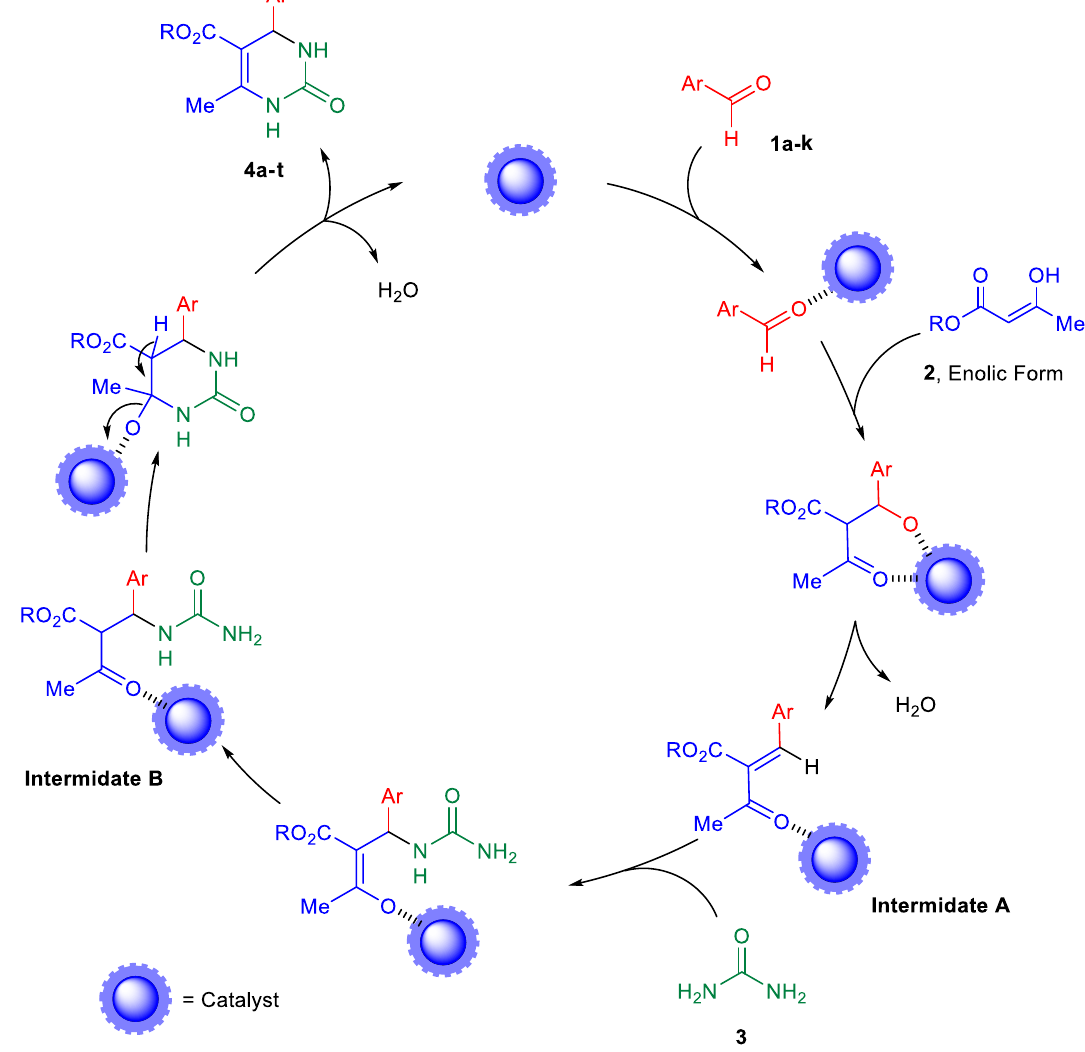
Figure 7. Proposed mechanistic route of MCRs Biginelli reaction catalyzed by NiO nanoparticles for the DHPMs